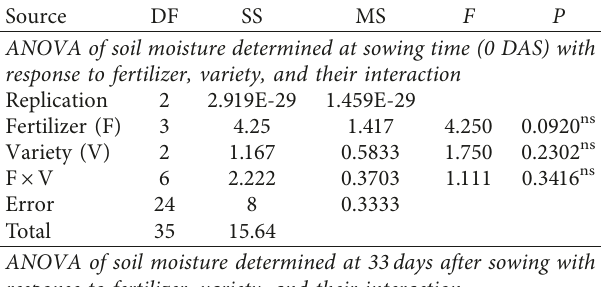
Table 3: Analysis of variance (ANOVA) for fertilizer rates, tef varieties, and their interaction effects on soil moisture determined at the different crop growth stages in northern Ethiopia (2013 cropping season).